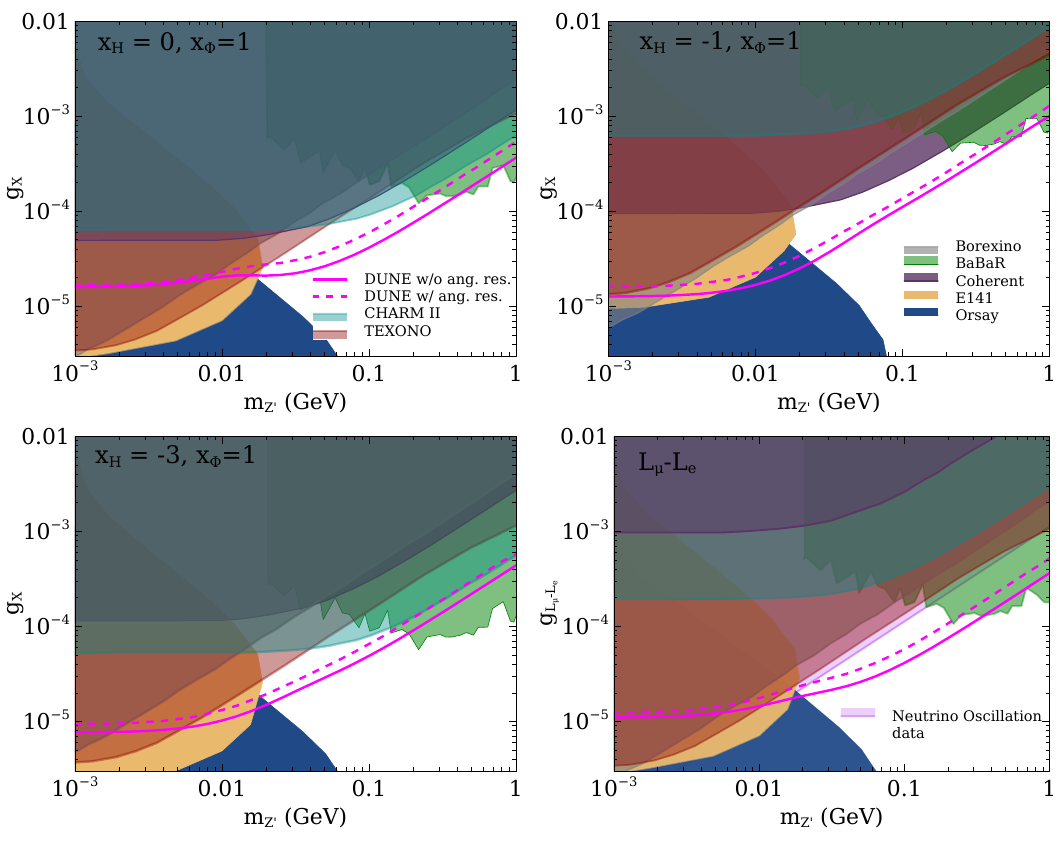
Figure 6 . 90 % CL contour on the g X -m z 0